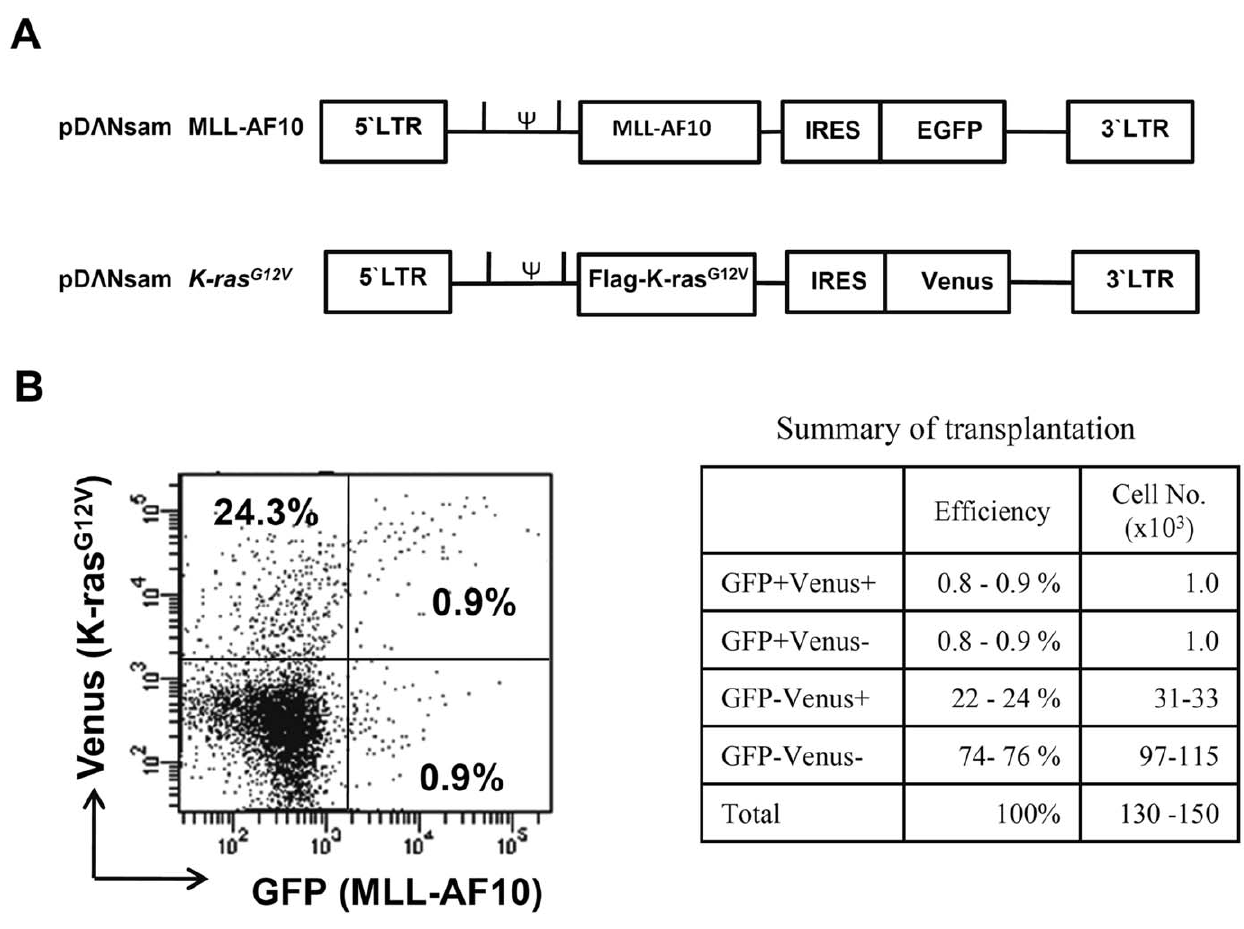
Figure 3. Co-transduction of activated K-ras and MLL-AF10 into CD34 + HSCs. (A) Schematic structure of the MLL-AF10-GFP and Flag-K- ras G12V -Venus vectors. (B) Infectious efficiency of the MLL-AF10-GFP and Flag-K-ras G12V -Venus co-transfection. The data and the summary shown in the flowcytometric analysis is representative of the transduced CD34 + HSCs in 2 experiments.